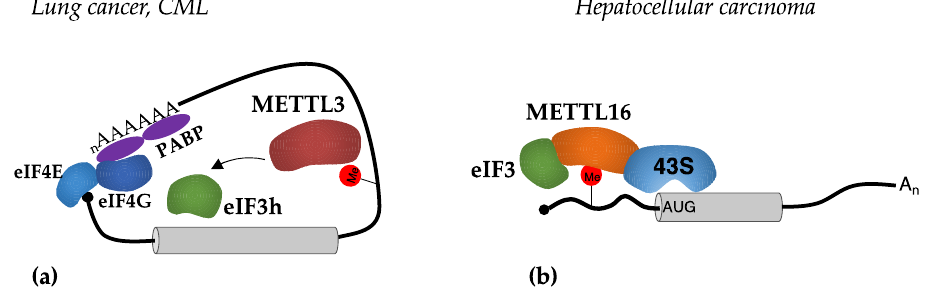
Figure 4. Mechanisms of translational regulation mediated by METTL3 and METTL16 methyltransferases. ( a ) The binding of METTL3 in m 6 A sites present in the 3 ′ -UTR stimulates translation initiation by recruiting eIF3h; ( b ) the binding of METTL16 in m 6 A sites present in the 5 ′ -UTR stimulates translation initiation by facilitating the interaction between the 43S PIC and the eIF3 translation initiation factor.